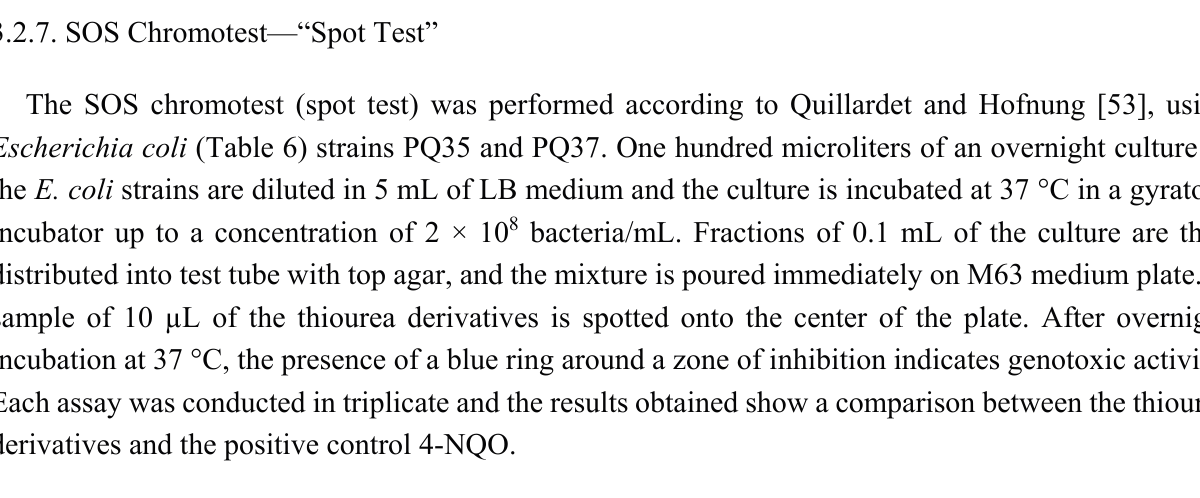
Table 6. Strains of Escherichia coli used in SOS chromotest—“Spot